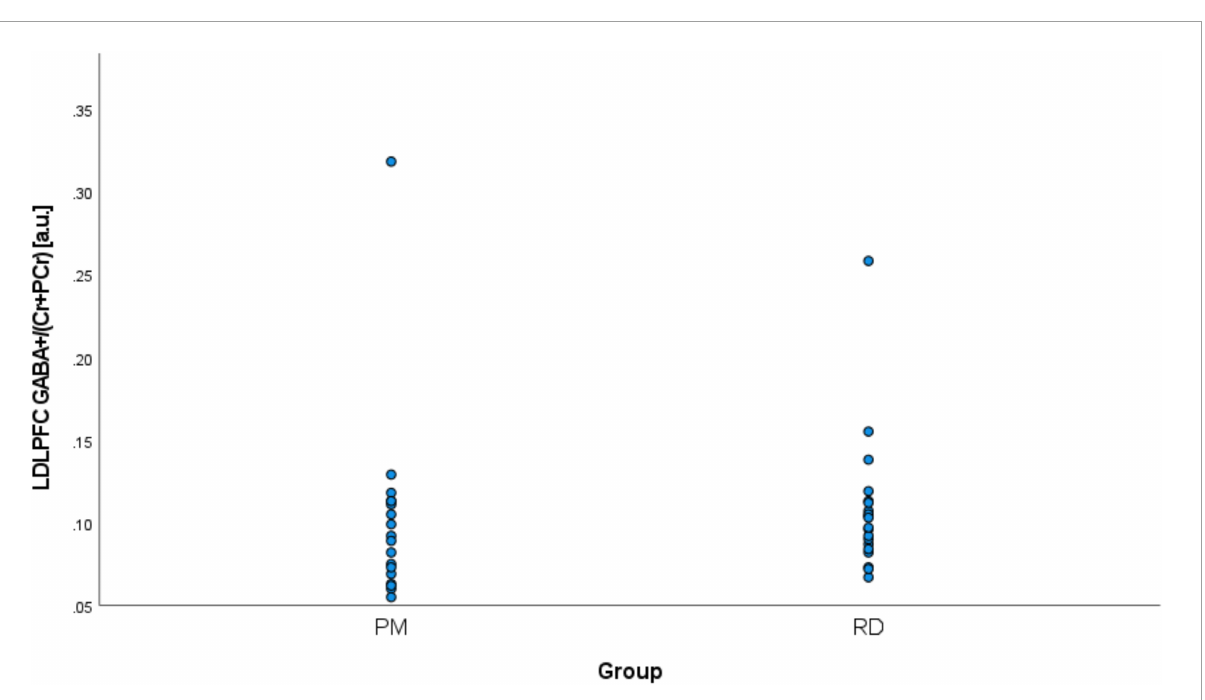
FIGURE4 Comparison of LDLPFC creatine and phosphocreatine-referenced GABA+ levels in healthy perimenopausal and reproductive-aged women. GABA+, gamma-aminobutyric acid including homocarnosine and macromolecules; LDLPFC, left dorsolateral prefrontal cortex; PM, healthy perimenopause; RD, healthy